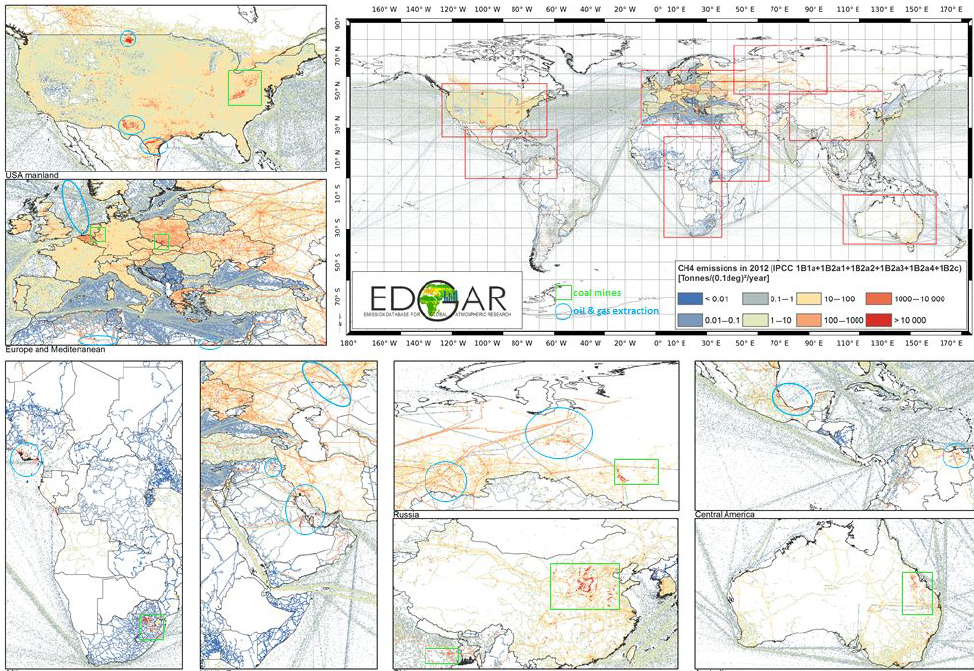
Figure 14. CH 4 emissions from fossil fuel production in 2012 with zoom on areas with intense coal mining (within green frame) and gas and oil production activities with venting (within blue circle). The shipping lines are representing the CH 4 leakage during transmission of oil tanker transport as fugitive emissions from the fuel and not as combustion emissions from the